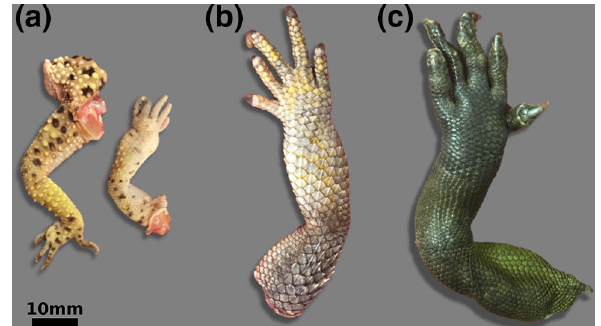
Figure 7. Exemplary selection of the animal limbs examined within this study. Excised limbs of a leopard gecko ( a ), a bearded dragon ( b ), and a water dragon ( c